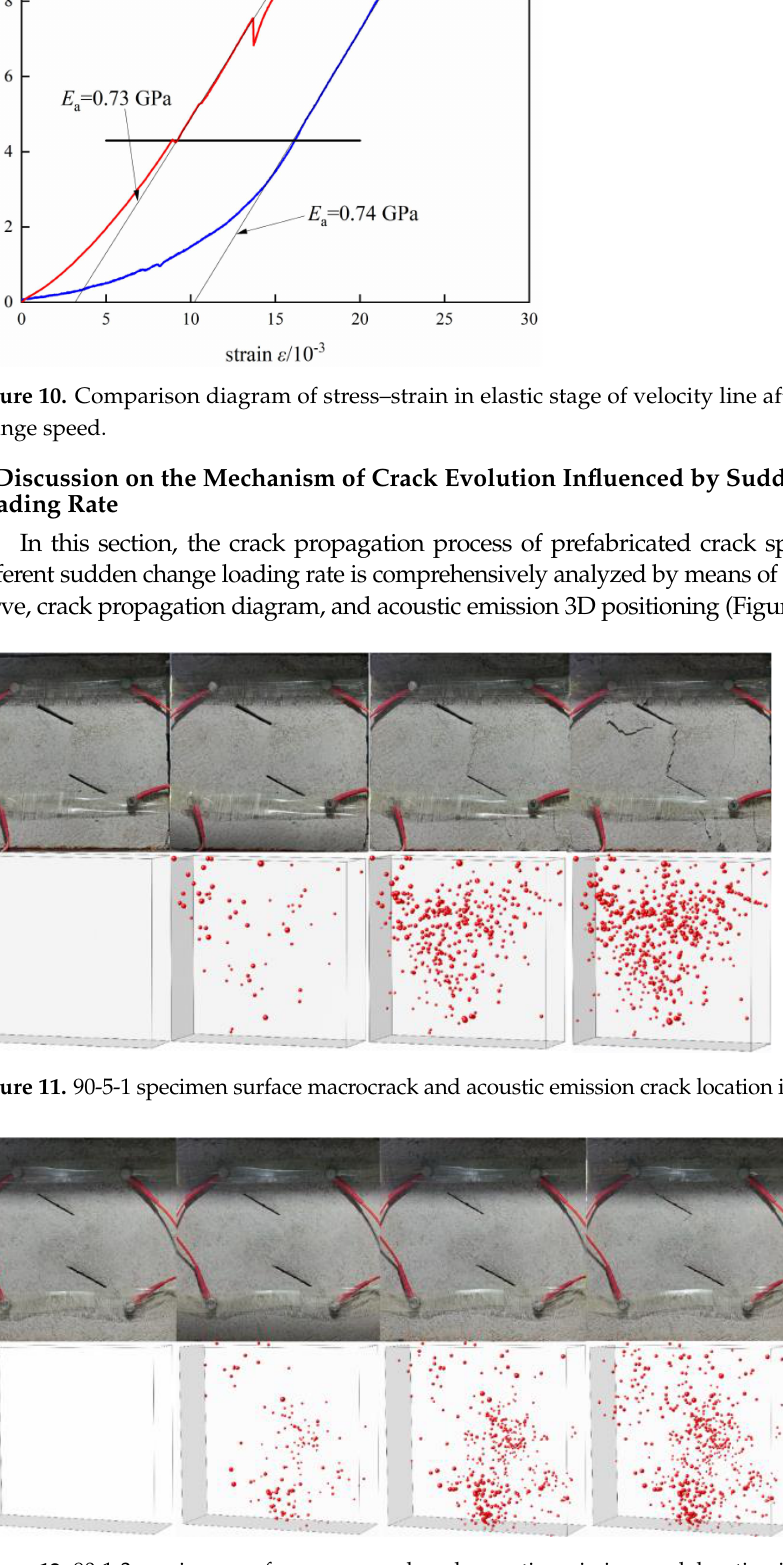
Figure 12. 90-1-3 specimen surface macrocrack and acoustic emission crack location information map.